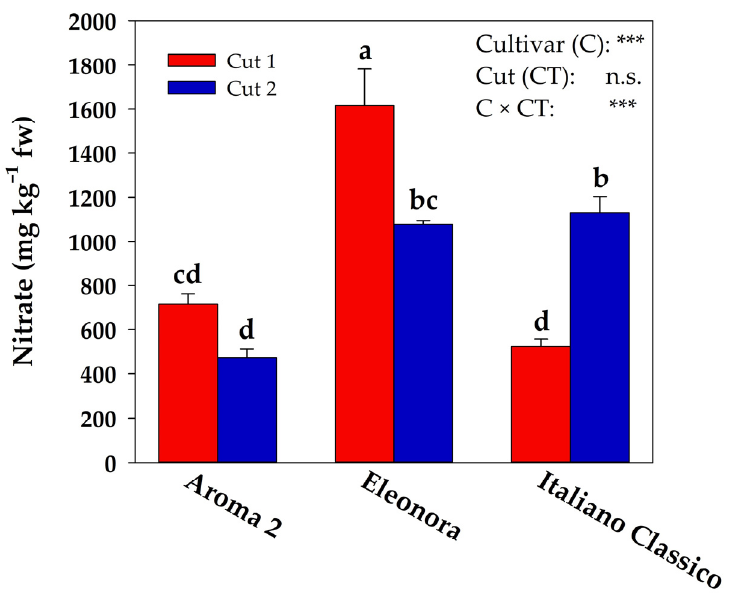
Figure 3. Nitrate content in different cultivars and cuts. n.s. and *** non-significant or significant at p ≤ 0.001, respectively. According to Duncan’s multiple range test ( p = 0.05), different letters indicate significant differences.